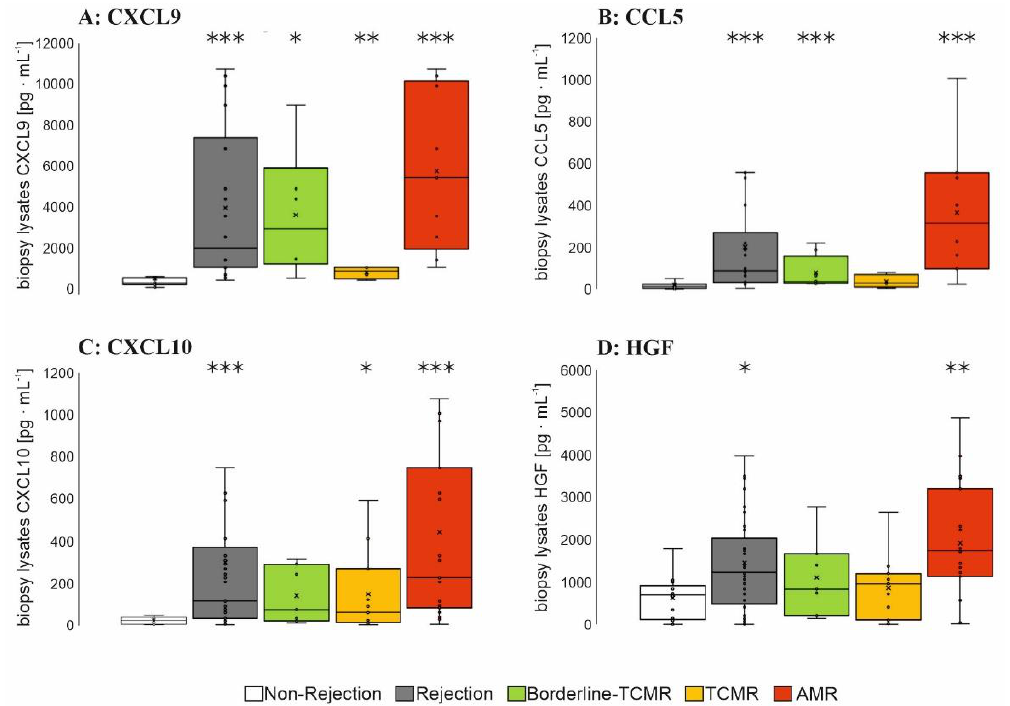
Figure 3. Multiplex ELISA analysis in biopsy lysates of the 1st patient cohort. Protein lysates were identified as inner cortex using microscopic analysis and grouped into non-rejection ( n = 11), borderline-TCMR ( n = 6), TCMR (T-cell mediated rejection, n = 9) and AMR (antibody-mediated rejection, n = 18). In total, 12.5 µg total protein was used to determine the concentrations of the cytokines/chemokines (( A ) CXCL9, ( B ) CCL5, ( C ) CXCL10 and ( D ) HGF) using Luminex-based multiplex assay. Boxplots show the median value, the mean and the standard error of the mean. Wilcoxon test revealed a statistical significance between groups with * p < 0,05, ** p < 0.01, *** p < 0.001 as indicated.